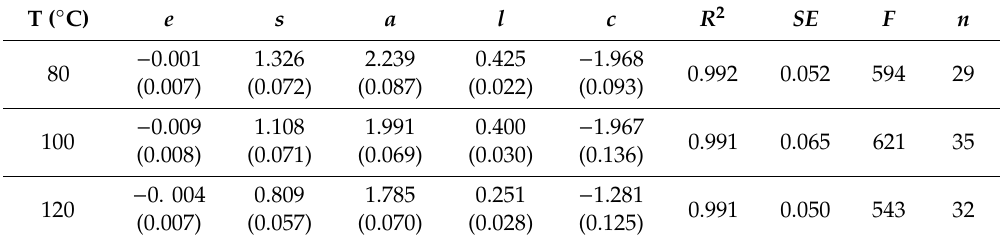
Table 2. Abraham system constants ( ± s.d.) of the PCL-PEG-PCL stationary phase ( b =